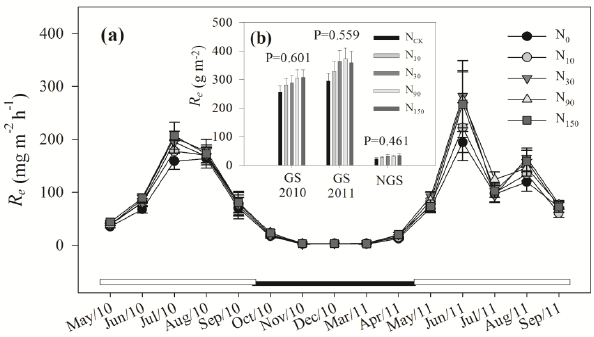
Fig. 1. CO 2 fluxes of ecosystem respiration ( R e ) at sites N 0 (ungrazed since 2005), N 10 (10kgNha − 1 yr − 1 ) , N 30 (30Nkgha − 1 yr − 1 ) , N 90 (90Nkgha − 1 yr − 1 ) and N 150 (150Nkgha − 1 yr − 1 ) within and outside the growing season using the static closed chamber method. White and black horizontal bars represent within (GS, 2010 and 2011) and outside (NGS) the growing season, respectively.